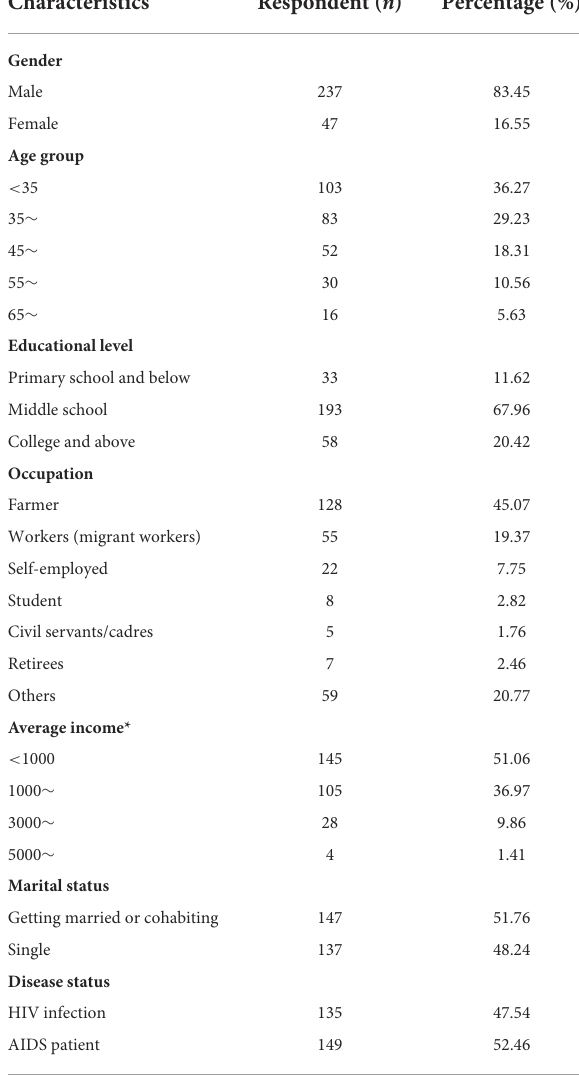
TABLE 1 Characteristics of participants ( n = 284). TABLE 2 The correlation between behavioral intention and other